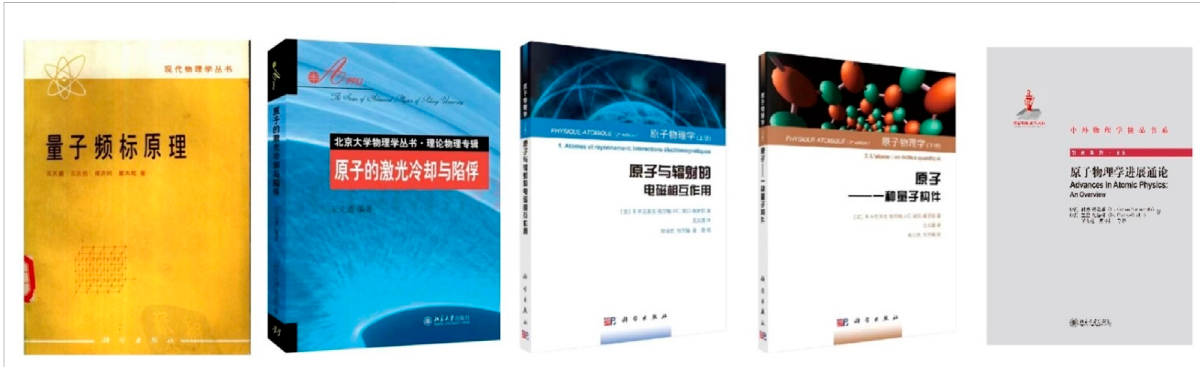
FIGURE 8 Books written or translated by Prof. Wang Yiqiu. From left to right: “ The Principles of Quantum Frequency Standards, ” “ Laser Cooling and Trapping of Atoms, ” “ Atomic Physics: Volume 1 ” (originally in French), “ Atomic Physics: Volume 2 ” (originally in French), and “ Advances in Atomic Physics: an Overview ” (originally in